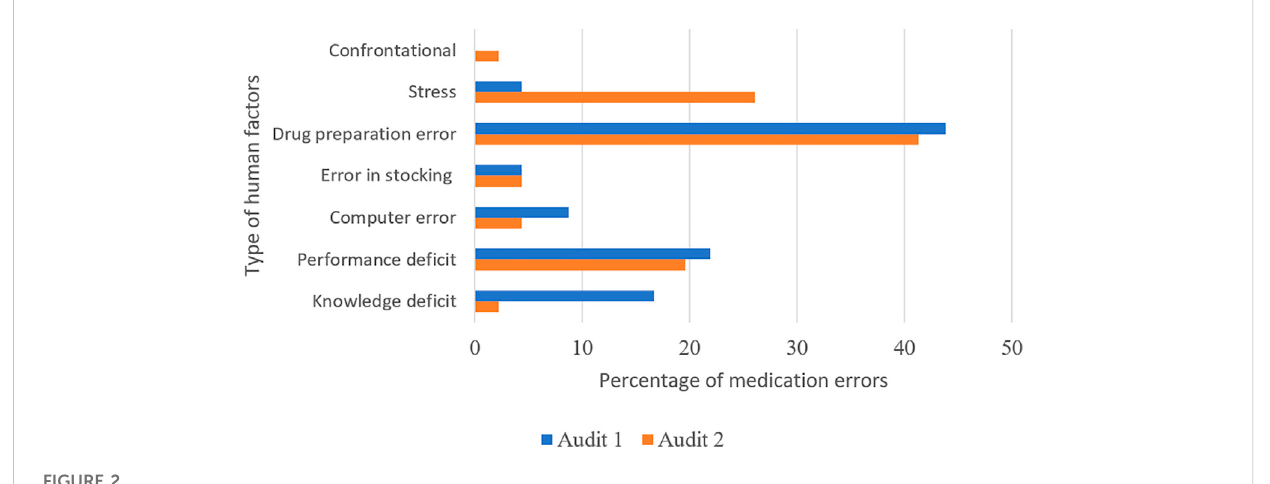
FIGURE 2 Details of medication errors caused by human factors.